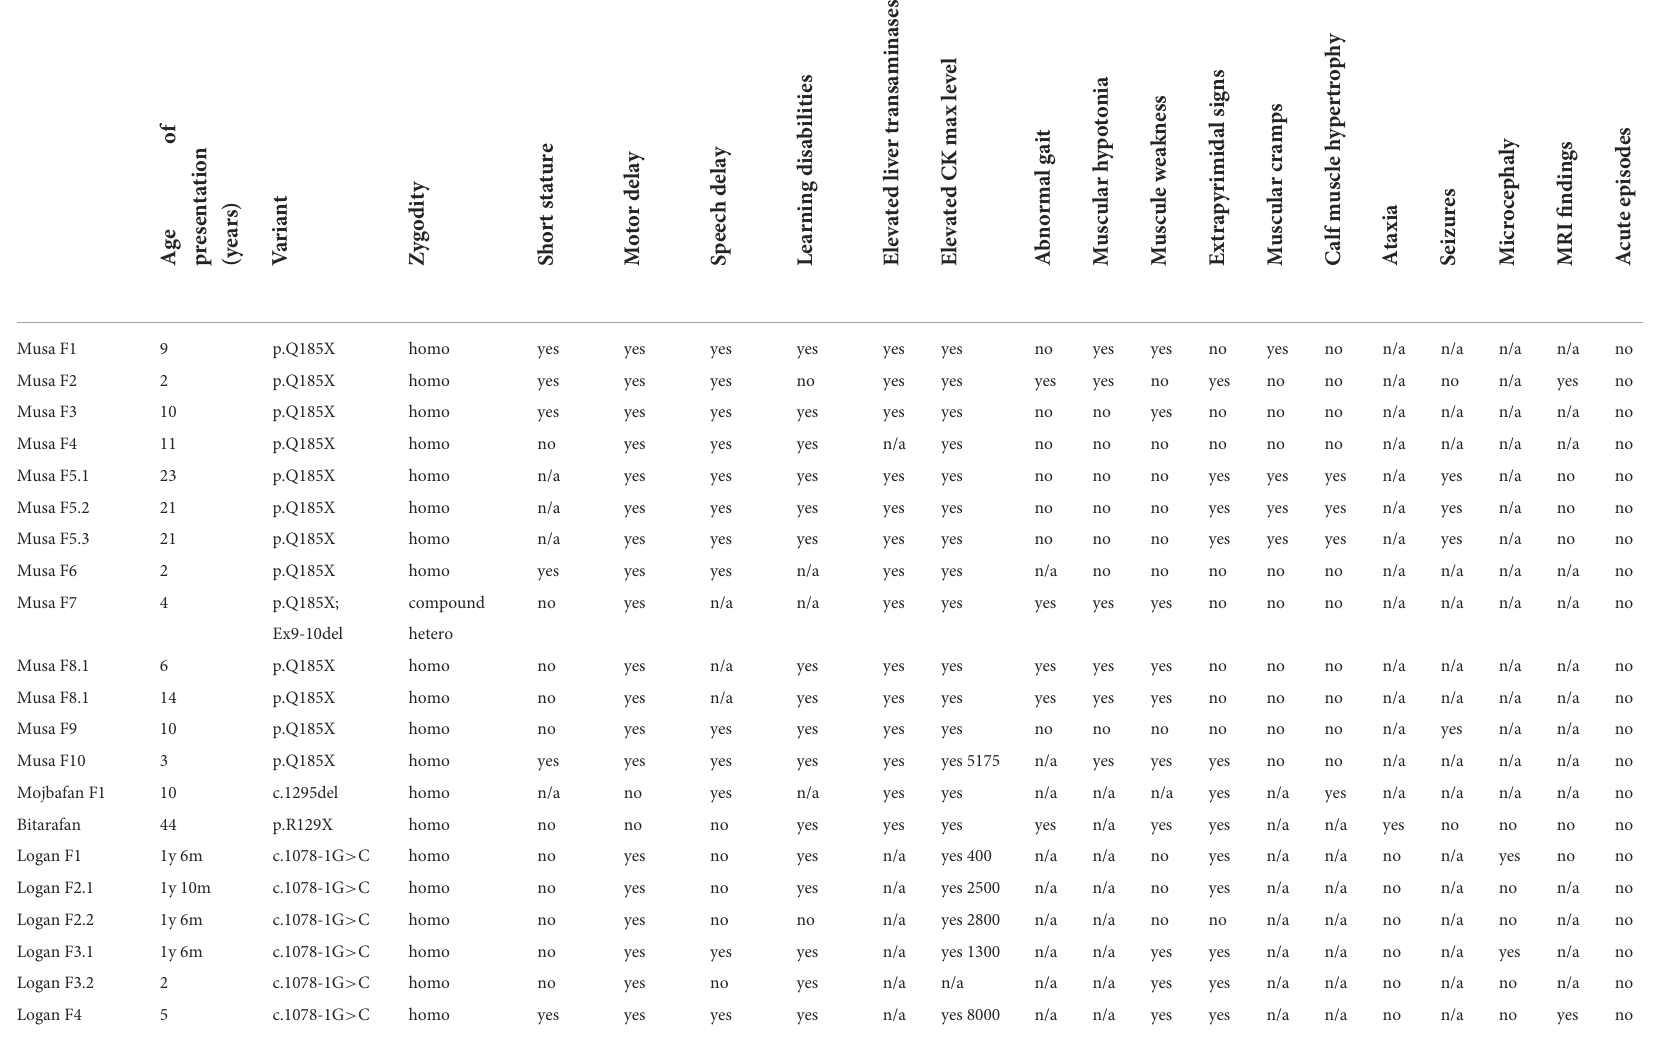
TABLE 1 Clinical characteristics of previously described